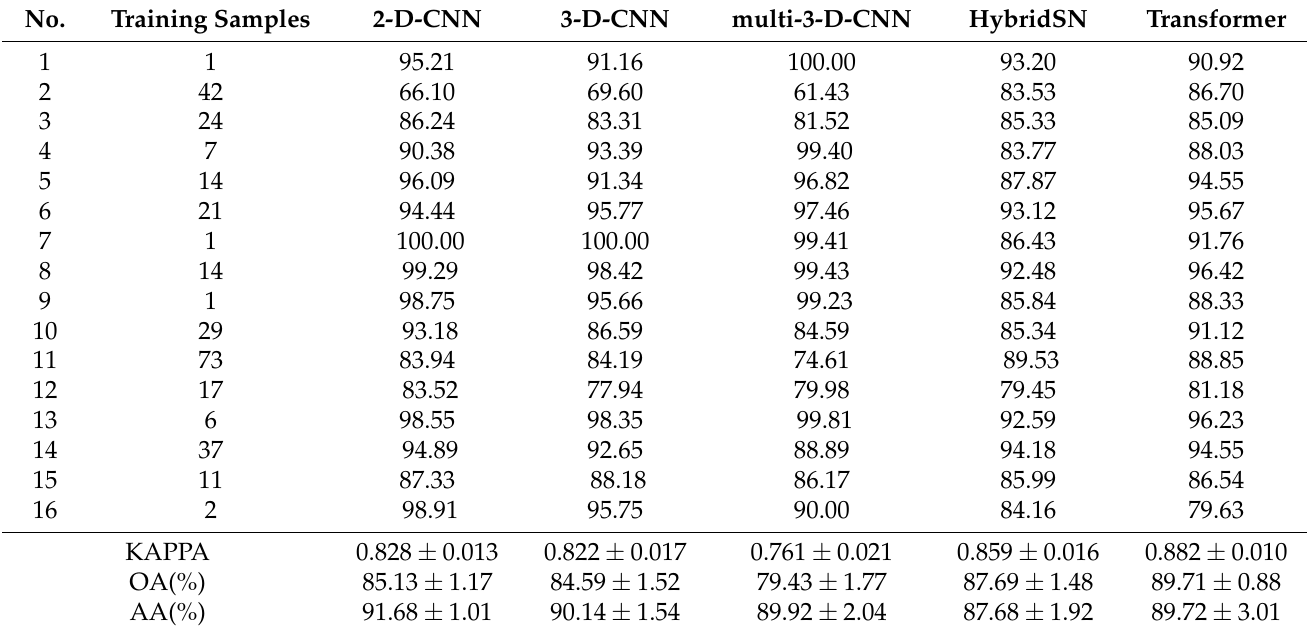
Figure 14. The classification maps of the University of Pavia. ( a ) Ground-truth map. ( b )–( f ) Classifi- Table 8. Classification results of different models in Indian